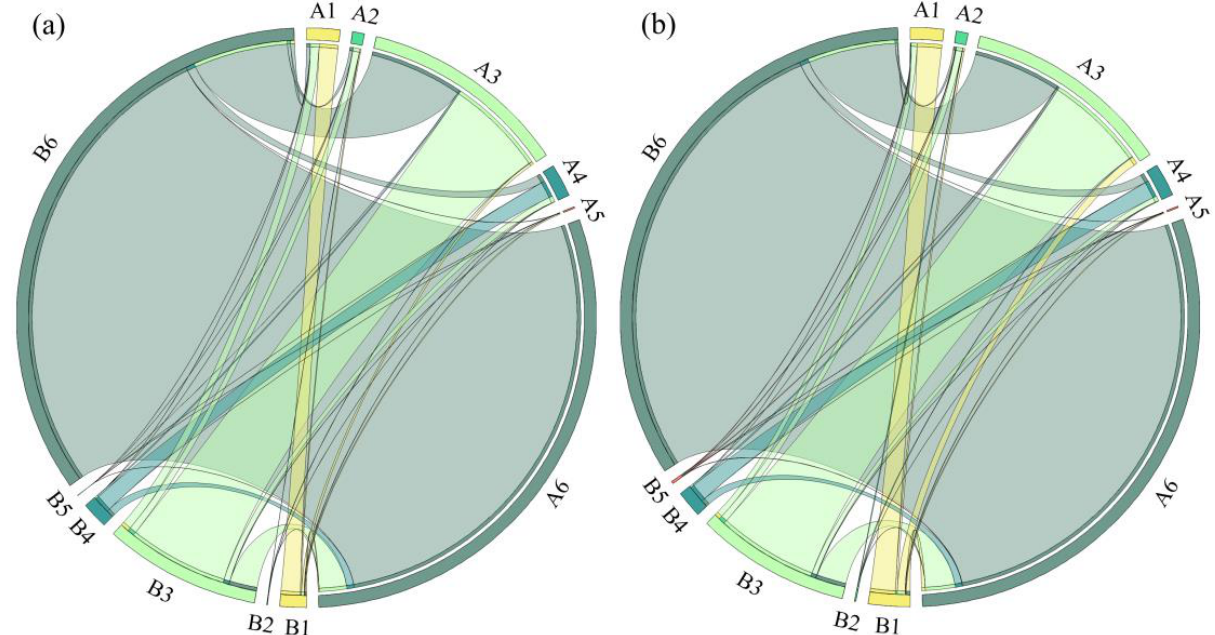
Figure 7. Map of future land use shifts in the Tarim River Basin. ( a ): 2020 – 2030 and ( b ): 1992 – 2030. From A1 to A6 are the land types in the starting years, while B1–B6 are land types in the end years. (A1/B1: Cropland, A2/B2: Grassland, A3/B3: Woodland, A4/B4: Built-up land, A5/B5: Water bodies, and A6/B6: Barren land).